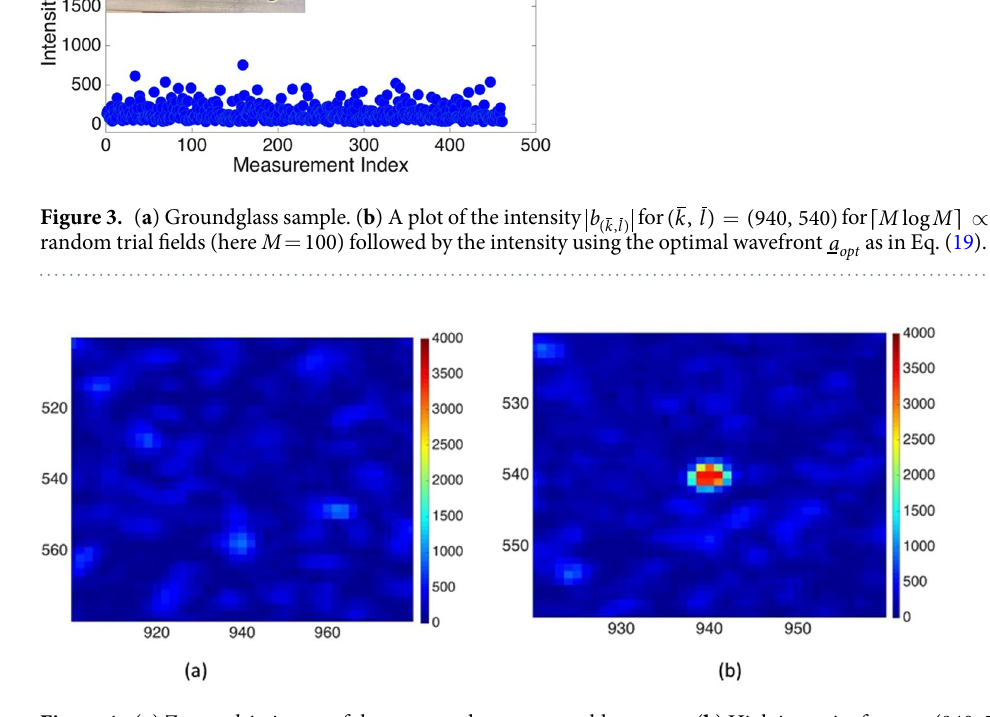
Figure 4. ( a ) Zoomed-in image of the measured average speckle pattern. ( b ) High intensity focus at (940, 540) obtained using the optimal